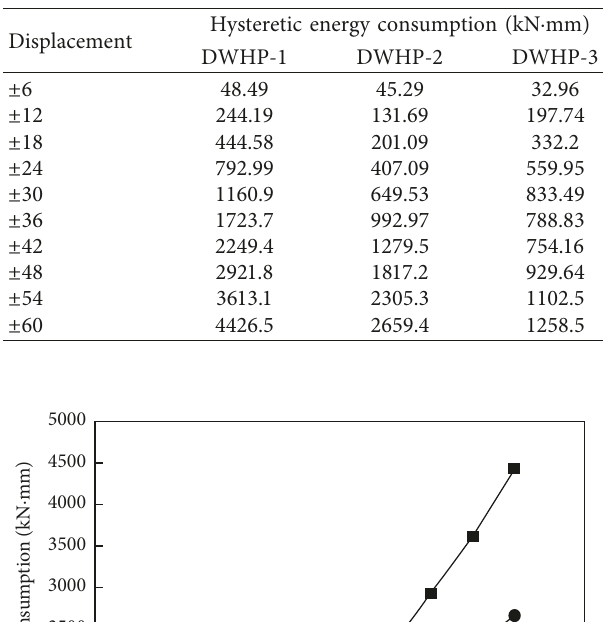
Table 3: Energy dissipation of each cycle of specimen displacement.